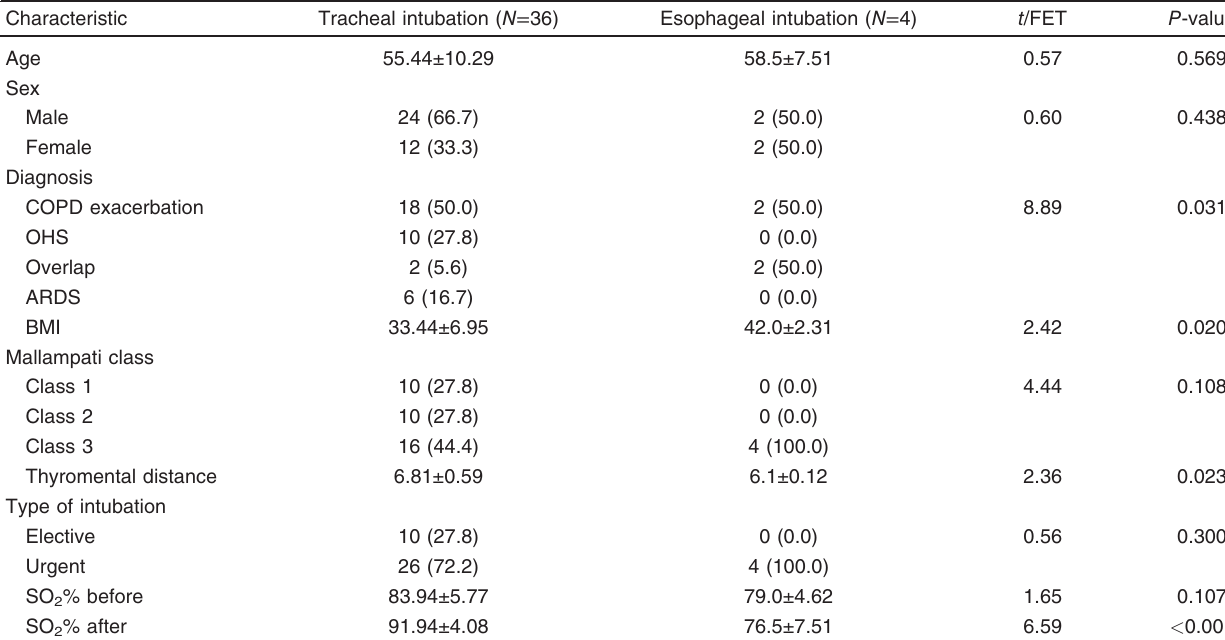
Table 2 General characteristics and airway data of both groups Characteristic